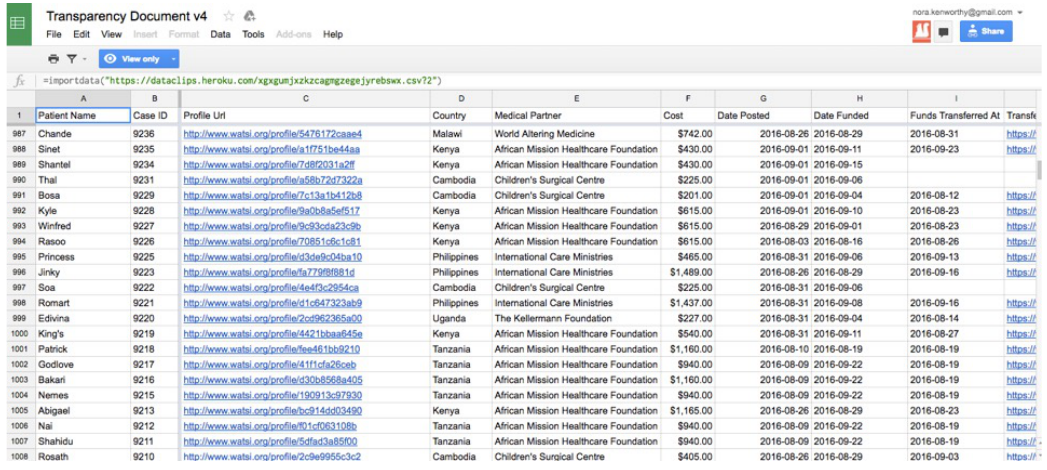
Figure 2. Watsi’s ‘transparency document’ (Watsi